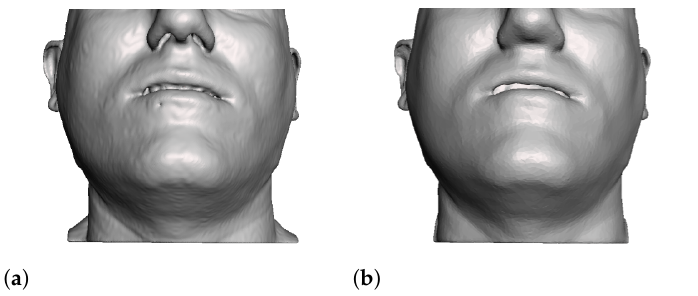
Figure 6. The preliminary segmentation of the skin mesh ( a ) is postprocessed to close small cavities and clean the surface ( b ).